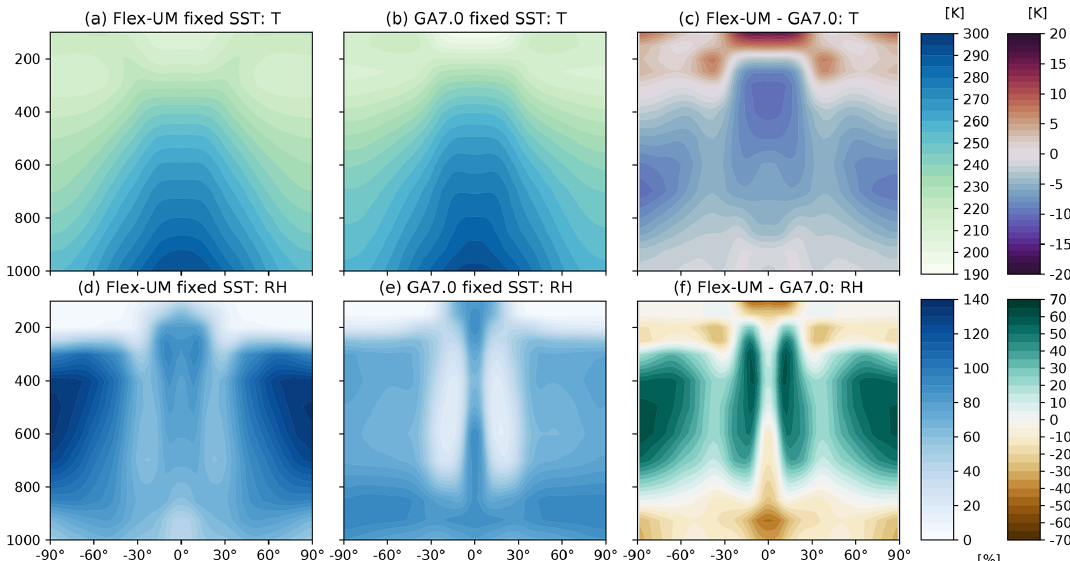
Figure 6. Fixed-SST aqua-planet model climatologies for Flex-UM (a, d) and GA7.0 (b, e) for temperature ( T in K, a, b, c ) and relative humidity (RH as a %, d, e, f ) on their native model grids. The differences between the models (Flex-UM – GA7.0) are plotted in panels (c, f) and are interpolated onto the Flex-UM grid.